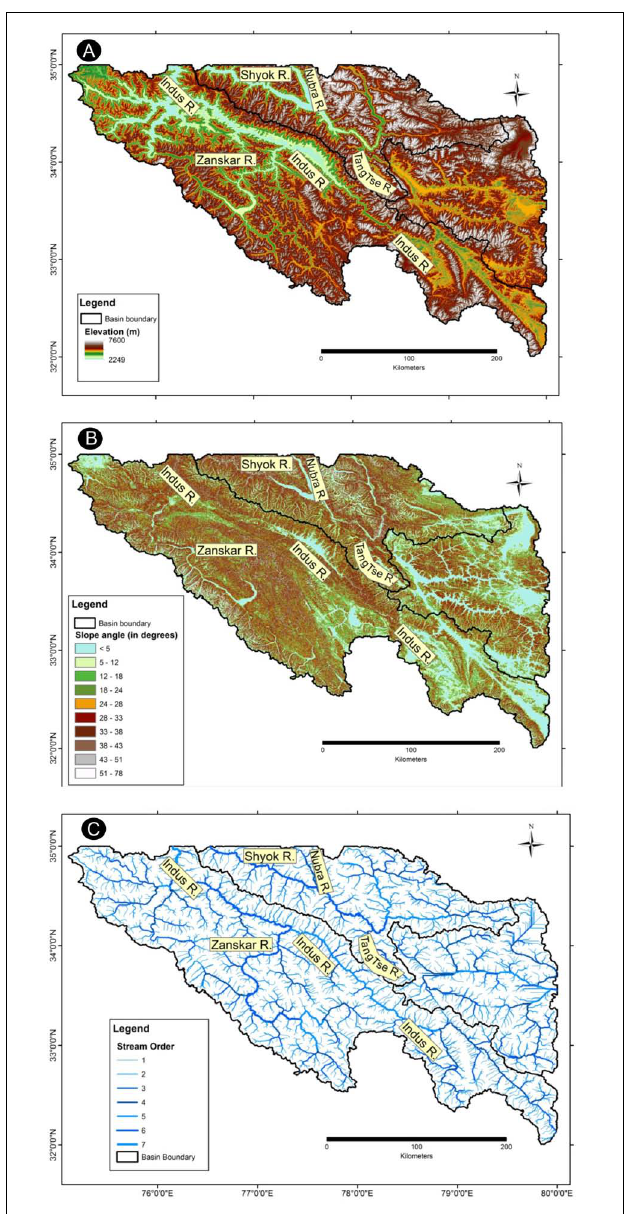
FIGURE 4 | Three maps panel of Upper Indus Basin Catchment (A) Map showing the altitude (DEM) variation within the catchment. (B) The slope map showing appreciable variation in the slope angle in a relatively limited distance of ∼ 400 km course of the Indus River. (C) The drainage map of the Indus catchment showing its major tributaries and minor streams. It is interesting to note that river Indus has attained 7th stream order, a feature usually seen in mountainous terrenes